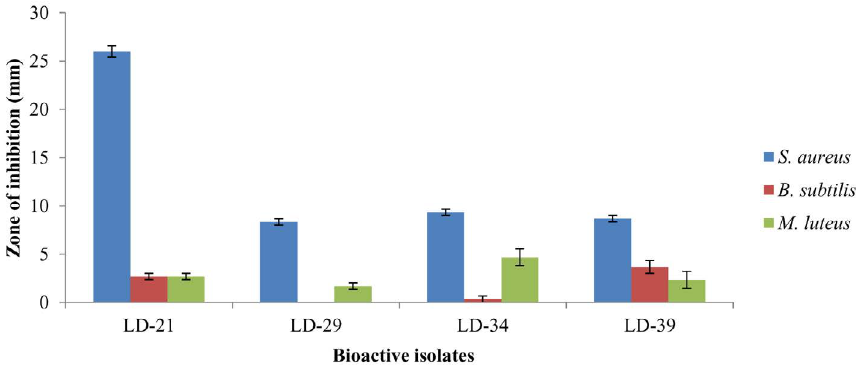
Fig.2. Antibacterial activity of culture filtrates prepared from the bioactive isolates by agar-well diffusion assay. (All the above bioactive isolates were identified as Streptomyces. S. aureus, Staphylococcus aureus MTCC 9886; B. subtilis, Bacillus subtilis MTCC 1305; M. luteus, Micrococcus luteus MTCC 1538. Vertical bars represent standard error of mean.)